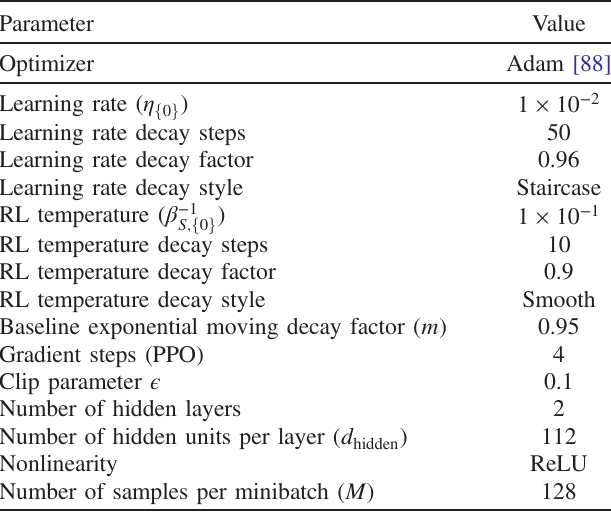
TABLE III. Hyperparameter values for training the autoregres- sive deep learning model. In the case of j A [cf. Eq. (3)], the total number of parameters is 24 431; for parameters is 21 985.